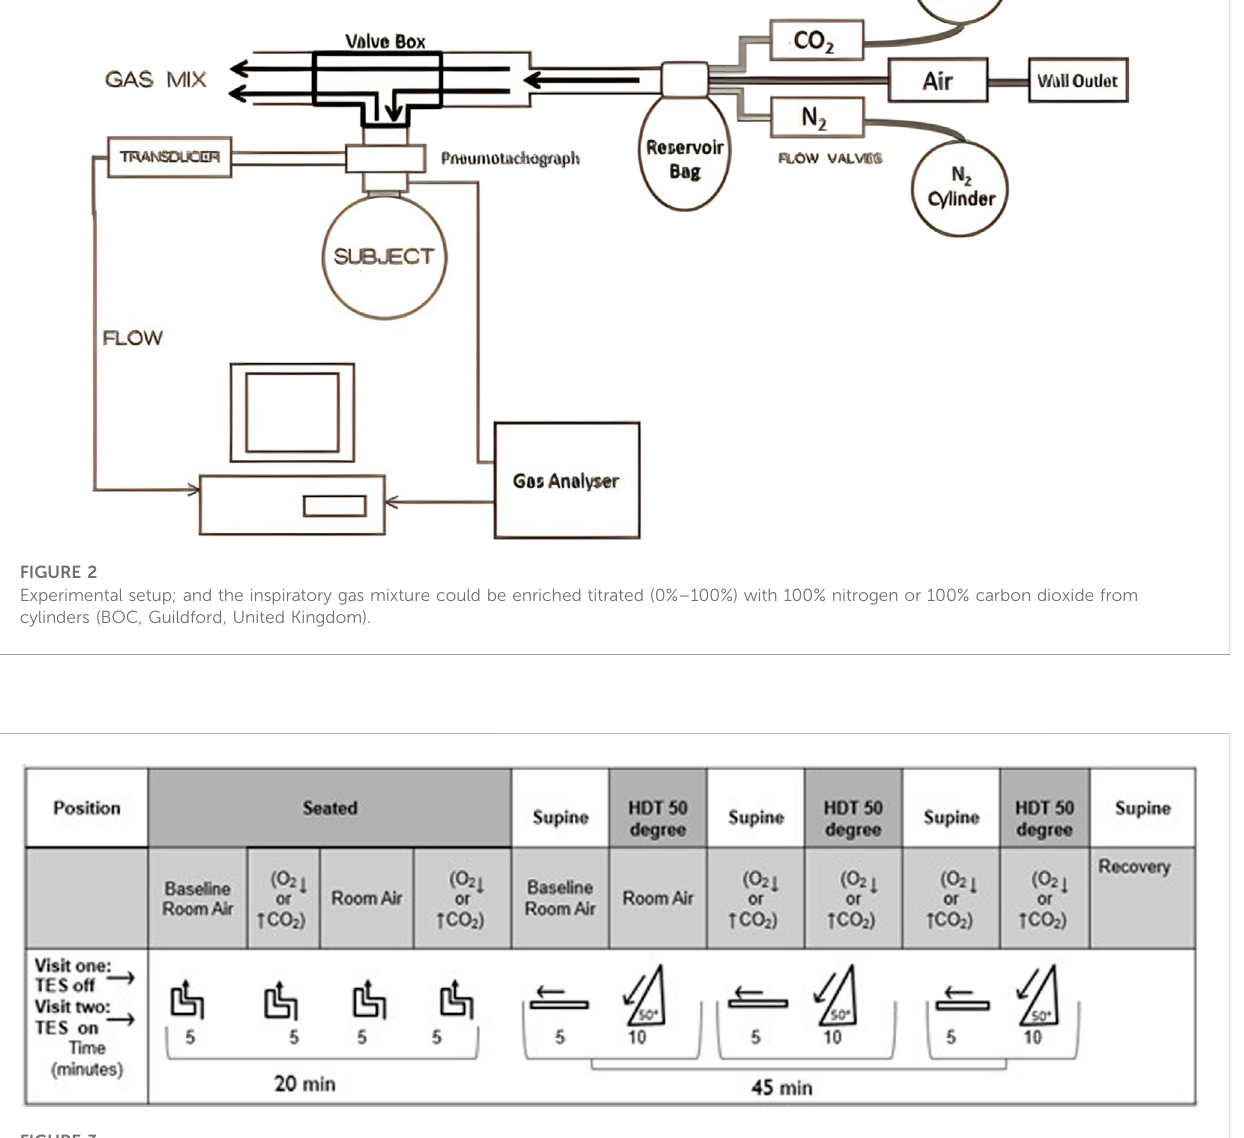
FIGURE 3 Schematic representation of study procedures. HDT: Head down Tilt. CO2: hypercapnic gas mixture (5% CO2). O2: hypoxic gas mixture (12% O2). Subjects were breathing room air, hypoxic, or hypercapnic gas mixtures in random order in seated, supine, and HDT (50) position. (off): electrical current off. (on): electrical current on (transcutaneous electrical nerve stimulation). Subjects were studied using each gas mixture for 5 min seated and supine, and for 10 min in HDT